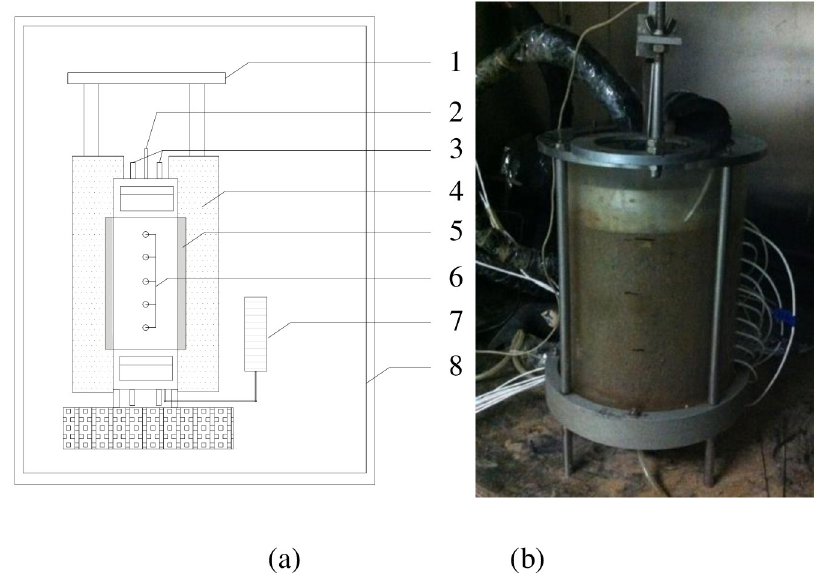
Fig 4. Experimental arrangement for soil freezing tests. (a) Apparatus and specimen profile and (b) image of the specimen: 1—Rigid frame; 2—displacement transducer; 3—inlet and outlet of cold bath; 4—insulating layer; 5— sample cell; 6—temperature probe; 7—Mariotte’s bottle; 8—temperature controlled chamber.